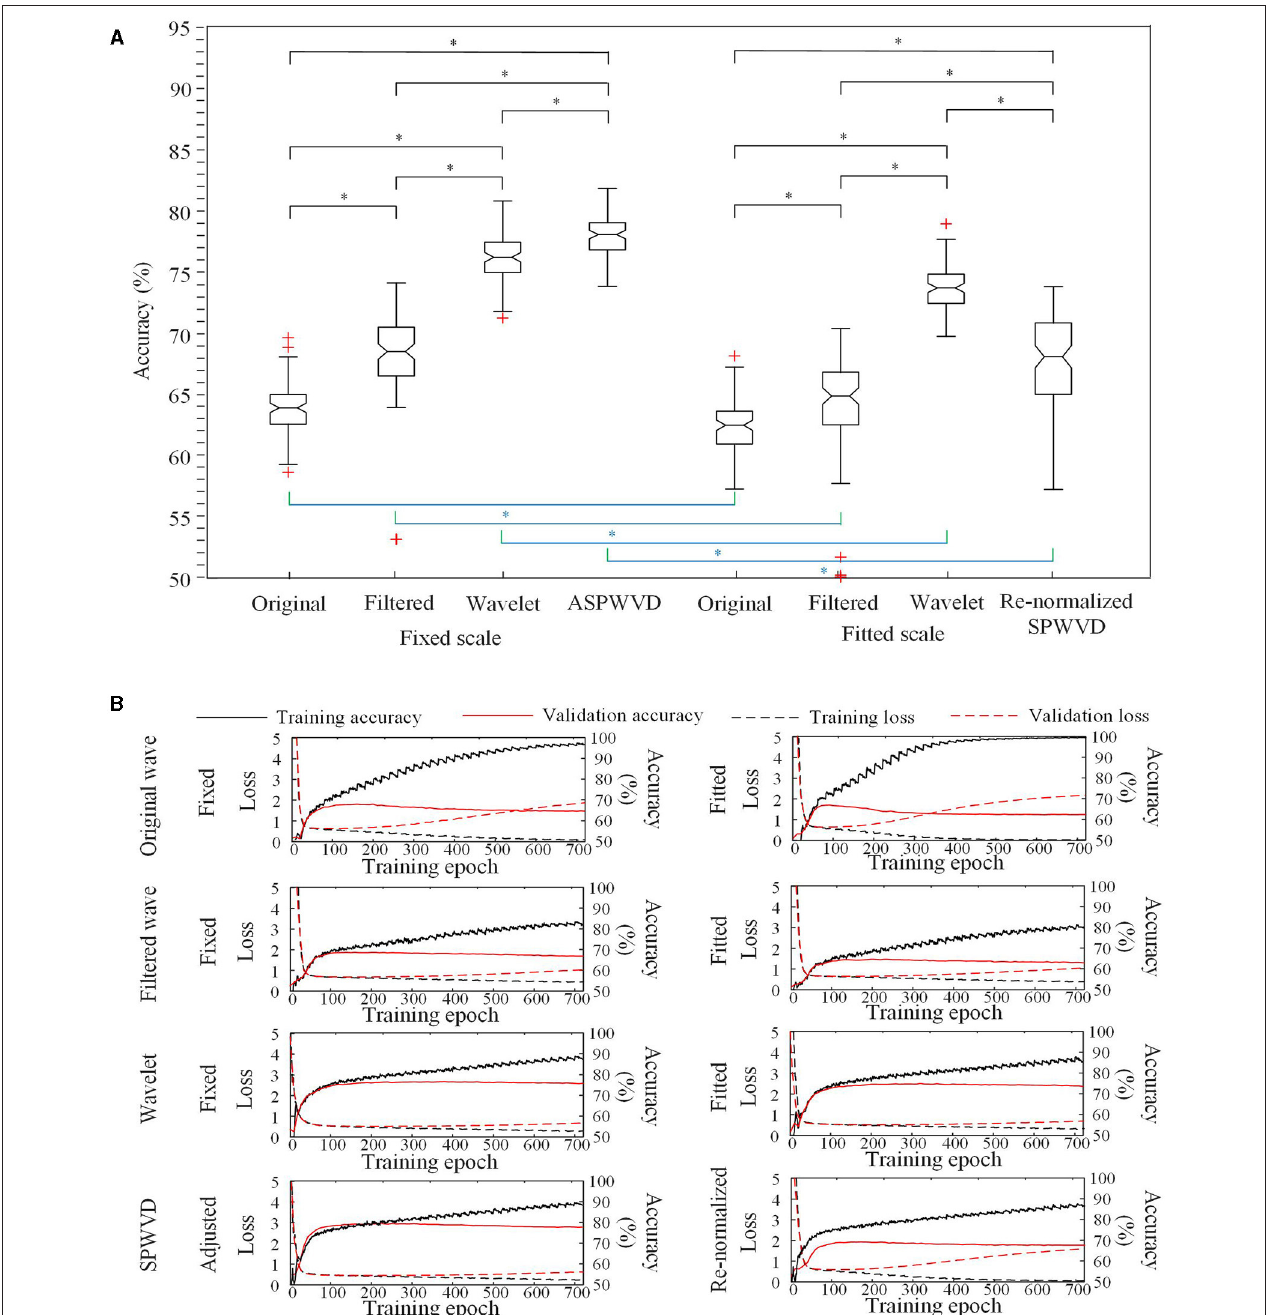
FIGURE 8 | CNN accuracies for FRs classification. (A) Accuracies of CNNs for FRs classification using various transformations. The CNN using the fixed-scale ASPWVD images provides the highest accuracy ( p < 0.05). The results from CNN models that are trained using fixed-scale images are significantly better than those from models trained using fitted-scale images ( p < 0.05). (B) CNN training and validation accuracies and losses are displayed. Asterisk (*) means a statistically significant difference.